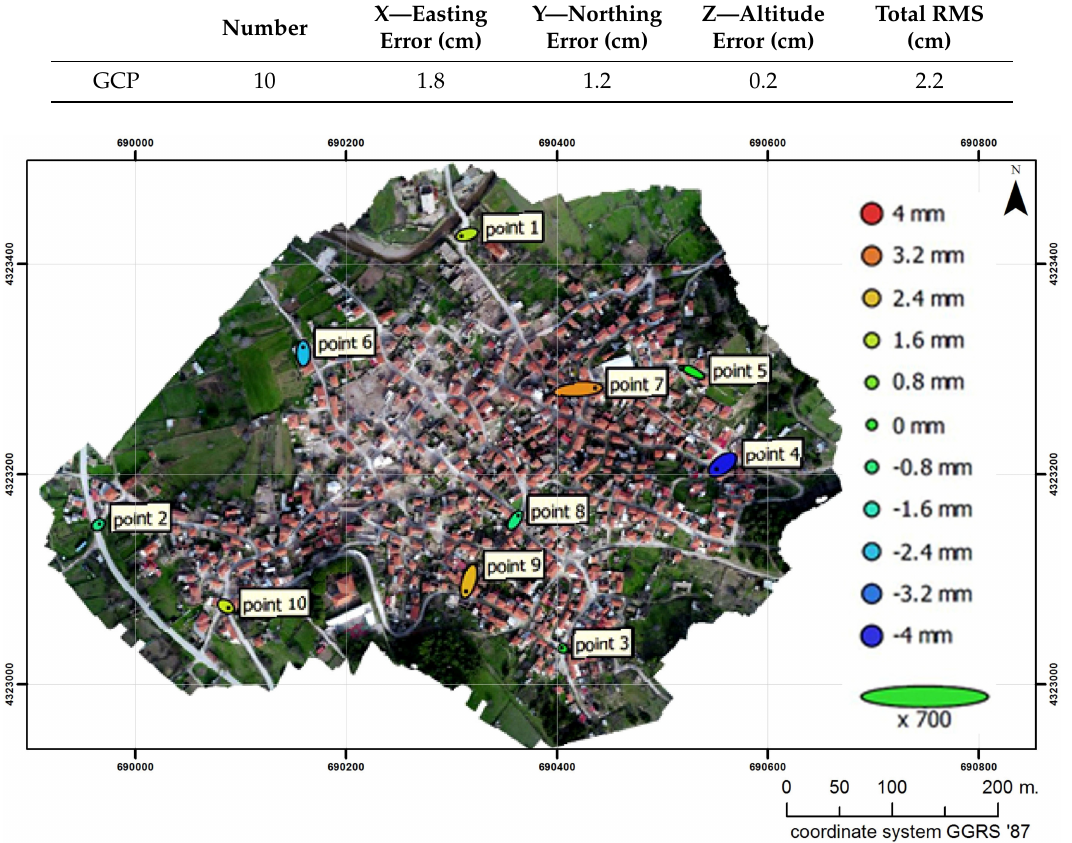
Table 1. List of the number and GCPs used and X, Y, Z, and Total RMS.